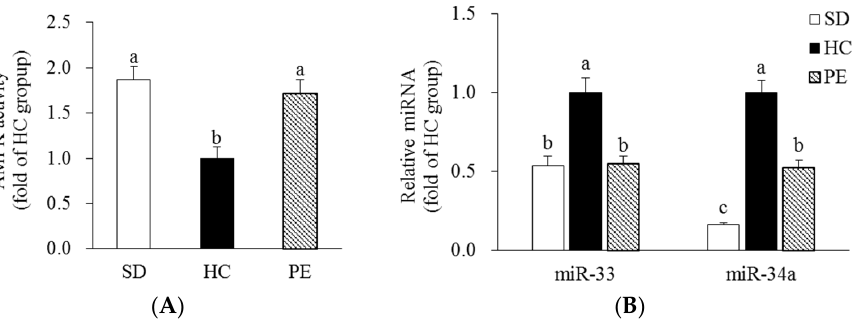
Figure 3. Effect of PE on AMPK activity ( A ) and miR ‐ 33/34a expression ( B ) in the liver. Data are expressed as mean ± SE ( n = 8). Bars with different letters (a, b, c) are statistically different at p < 0.05 by Tukey’s test. SD, standard diet; HC, high ‐ cholesterol diet; PE, HC + 0.8% extruded Portulaca oleracea L. extract; AMPK, AMP ‐ activated protein kinase; miR, microRNA.